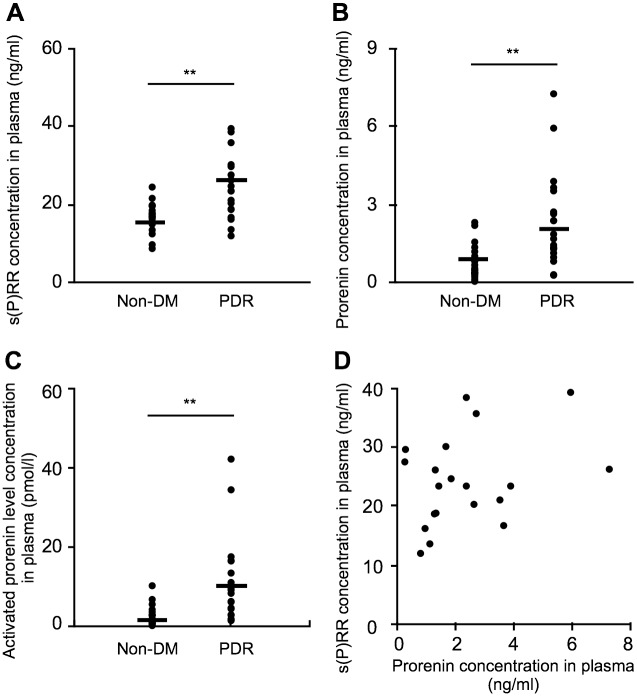
Upregulation of s(P)RR, prorenin and activated prorenin protein levels in the plasma of PDR patients.Protein levels of s(P)RR (A), prorenin (B), and activated prorenin (C) in the plasma of the non-DM and PDR subjects. Black symbols indicate individual samples. n = 20 in each group, **p < 0.01, Student’s t test. (D) Correlation between s(P)RR and prorenin was not detected in the plasma of patients with PDR (n = 20, Spearman rank correlation).